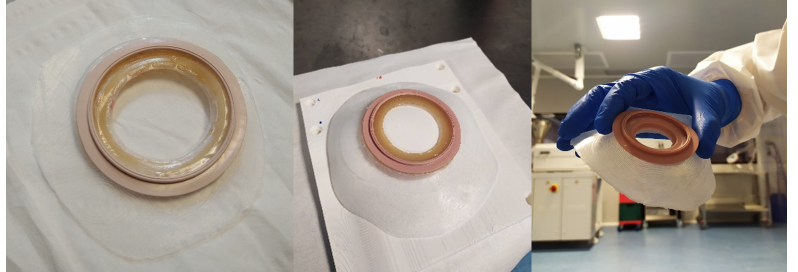
Figure 24. The three stoma patches produced for a patient of the clinical trial. From left to right, using CT scan, Structure Sensor and Go!Scan